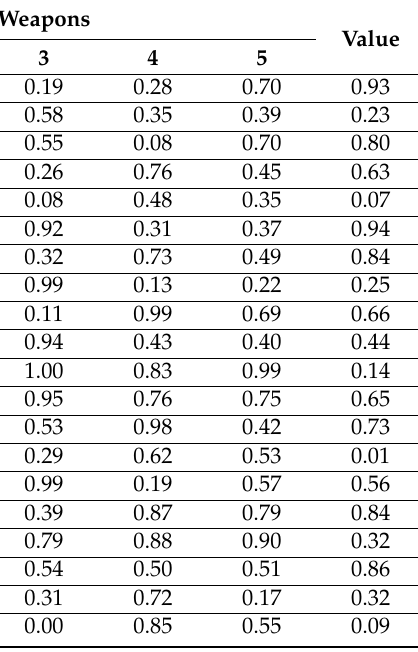
Table A8. Details of the destructive value of every target and the probability of kill for every weapon in the two component tasks of problem 8 in Table 2. Each task is a WTA